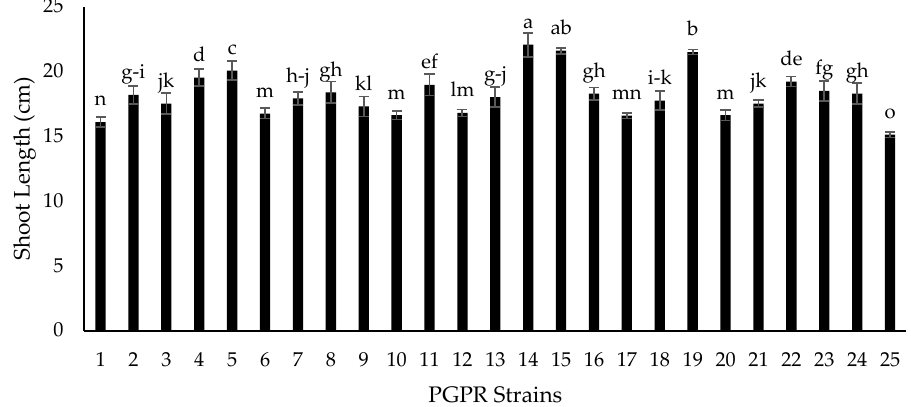
Figure 7. E ff ect of plant growth promoting rhizobacteria (PGPR) strains on chickpea shoot length (cm). Strains (1–24) are PGPRs (RS-01 to RS-24) while 25 is the control treatment. The bars indicate standard error ( ± SE) of the mean ( n = 3). Means followed by the same letter within the bars are not significantly di ff erent at p = 0.05.